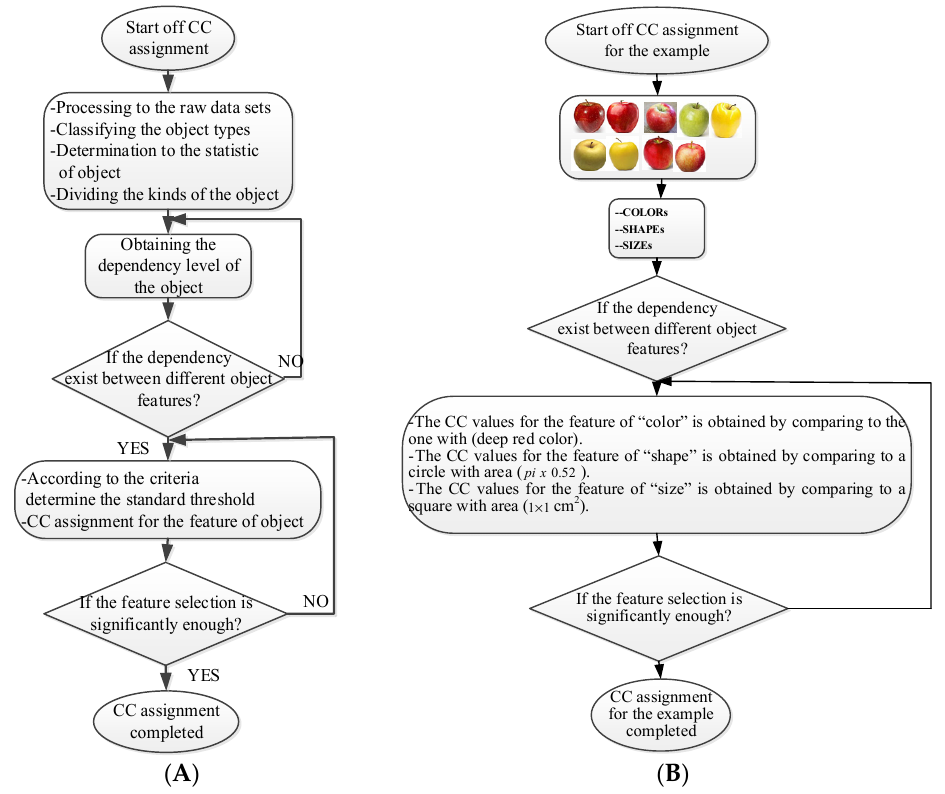
Figure 1. The algorithms for the proposed CC assignment scheme. ( A ) Flow chart of CC assignment; ( B ) Detail flow chart of CC assignment.